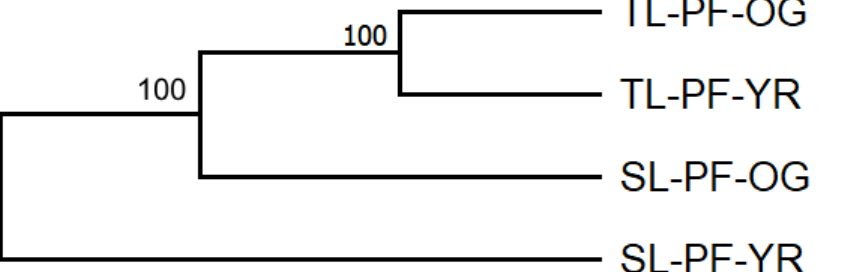
Figure 3. The UPGMA dendrogram, based on genetic distances. The number on the nodes represents the percent bootstrap support from 1000 bootstraps. Details of the populations are provided in Table 1. The summary bar plot of the estimated membership coefficient (Q) of the stud- ied white spruce individuals from four populations from the STRUCTURE analysis for K = 2–8 is presented in Figure 4. We observed the most prominent peak at Delta K = 4 after Evanno et al. [54] adjustments in STRUCTURE HARVESTER [55] (Figure 5A). Thus, STRUCTURE revealed four genetic groups admixed within and among four populations of white spruce (Figure 5B). The STRUCTURE analysis did not separate the two groups (PF-OG and PF-YR) of populations at K = 2 or any other K values (Figure